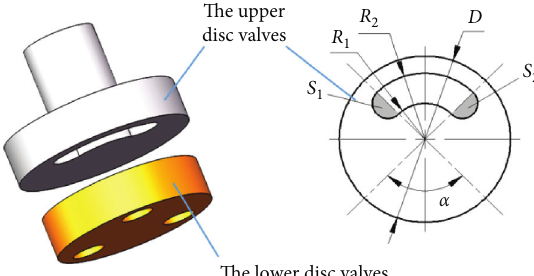
Figure 3: Schematic diagram of disc valve structure